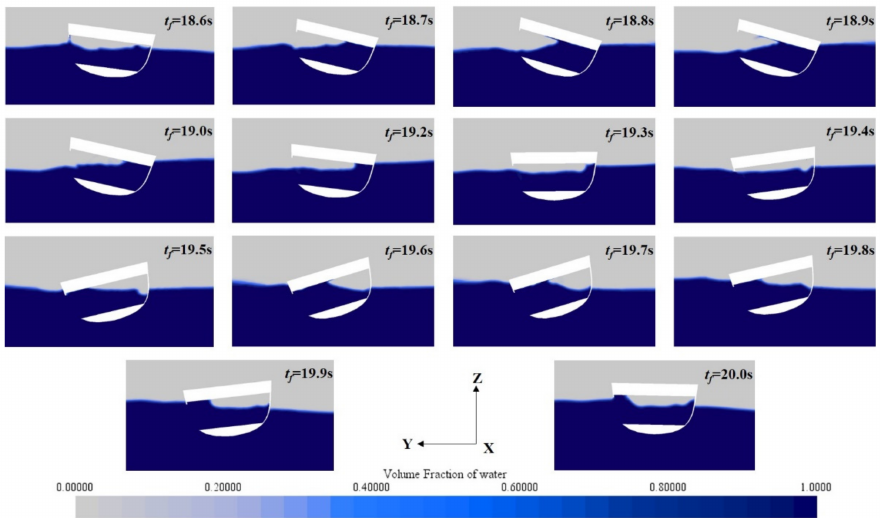
Figure 15. Representative snapshots of the internal wave motion in the damaged